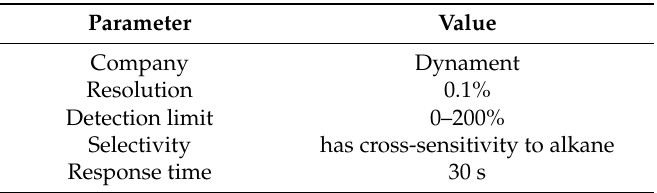
Figure 1. Schematic diagram of the structure of the mixed natural gas online testing system (the inserted pictures are the photos of the corresponding parts). Table 1. Detailed information about our